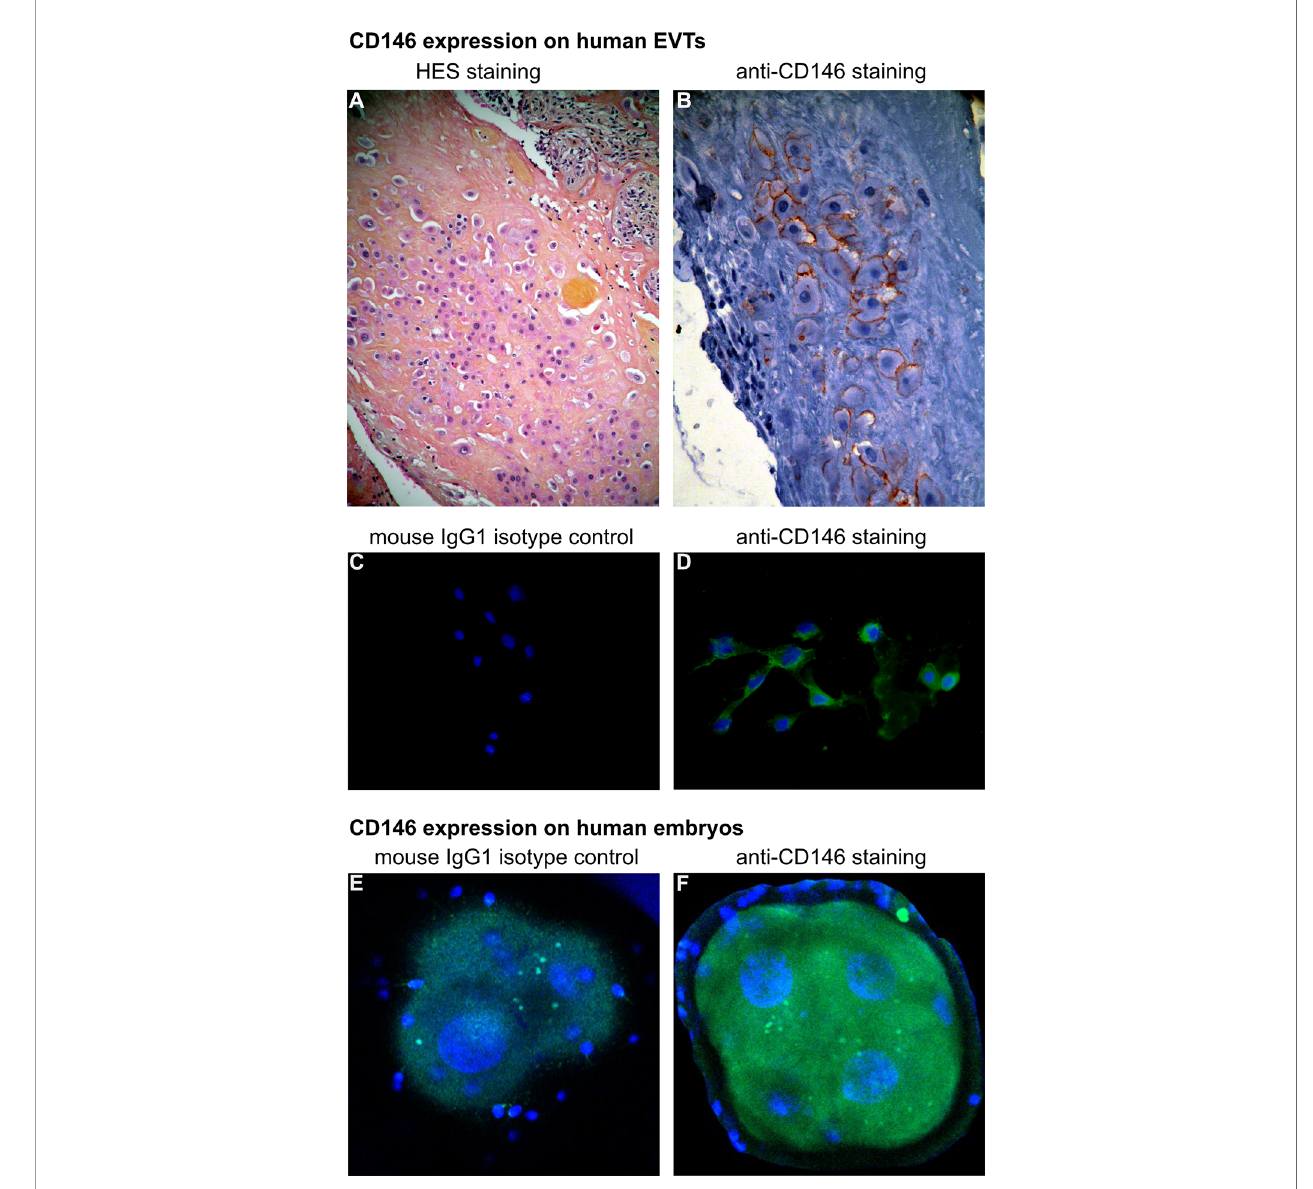
FIGURE 1 | CD146 expression on human extravillous trophoblasts (EVTs) and embryos. (A, B) Characterization of EVTs in human placenta, from a normal term pregnancy. (A) EVTs are stained with hematoxylin and eosin (H&E) (objective 10×). (B) Immunohistochemistry with avidin – biotin – peroxidase complex, with CD146 antibody (monoclonal mouse antihuman, BioCytex S-Endo 1S-Endo1) (objective 20×). (C, D) Expression of CD146 on EVTs outgrowth from human placental villous explants culture ( ex vivo model) [for model, see Kaspi et al., (18)]. (C) Cells were labeled with mouse IgG1 isotype control and (D) anti-CD146 antibody (Novocastra-Leica N1238). 4 ′ ,6-Diamidino-2-phenylindole (DAPI) was used to counterstain DNA (objective 20×). (E, F) Expression of CD146 on early embryo stage (day 2): immunostaining of (E) mouse IgG1 isotype control and (F) anti-CD146 (S-Endo1). DAPI was used to counterstain DNA. [Picture is from Bouvier et al, (24)] (objective